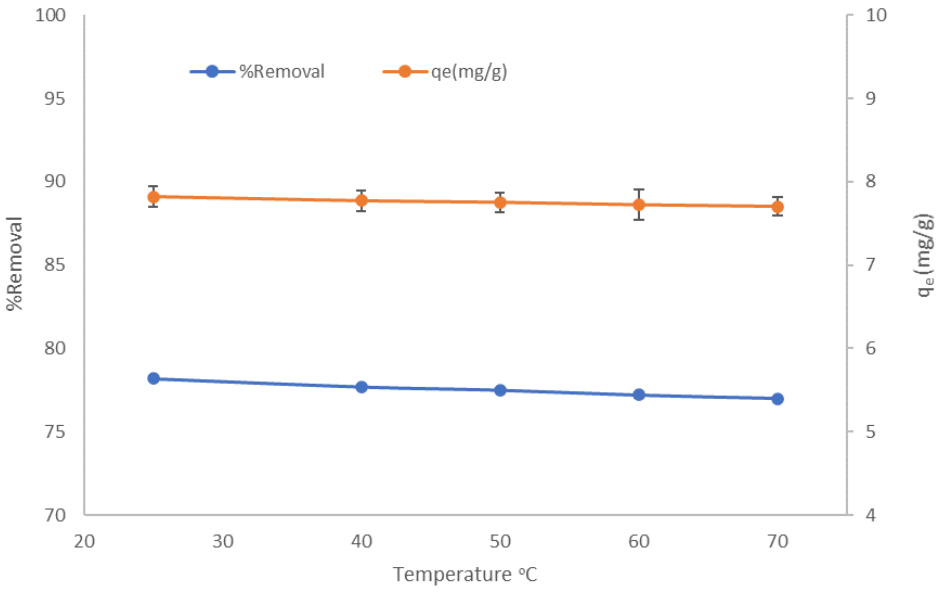
Figure 11. Effect of temperature on % removal and adsorption capacity using LCF.